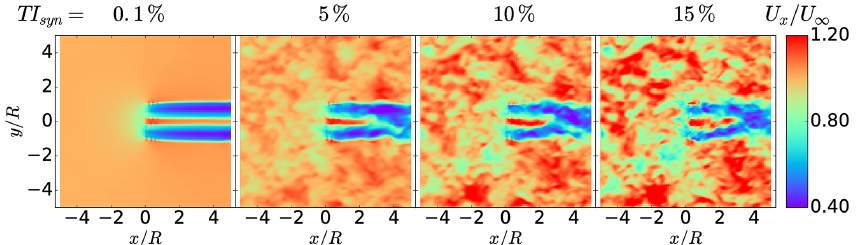
Figure 12. Normalized instantaneous axial velocity component U x /U ∞ of wind turbine wake immersed in HIT for different turbulence intensities.